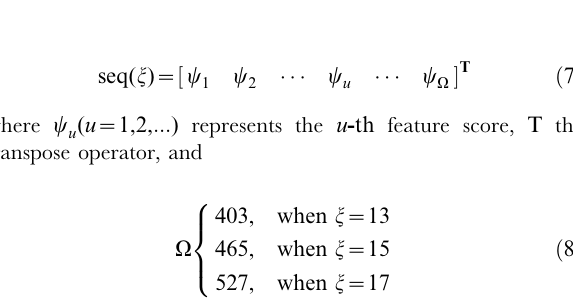
Figure 3. A 2-dimensional histogram to characterize the PSSM features in the final optimal features set. ( A ) The impact on the domain prediction from the mutation to each of the 20 amino acid types. ( B ) The evolutional conservation status for each of the 13 subsites. See the text for further explanation.